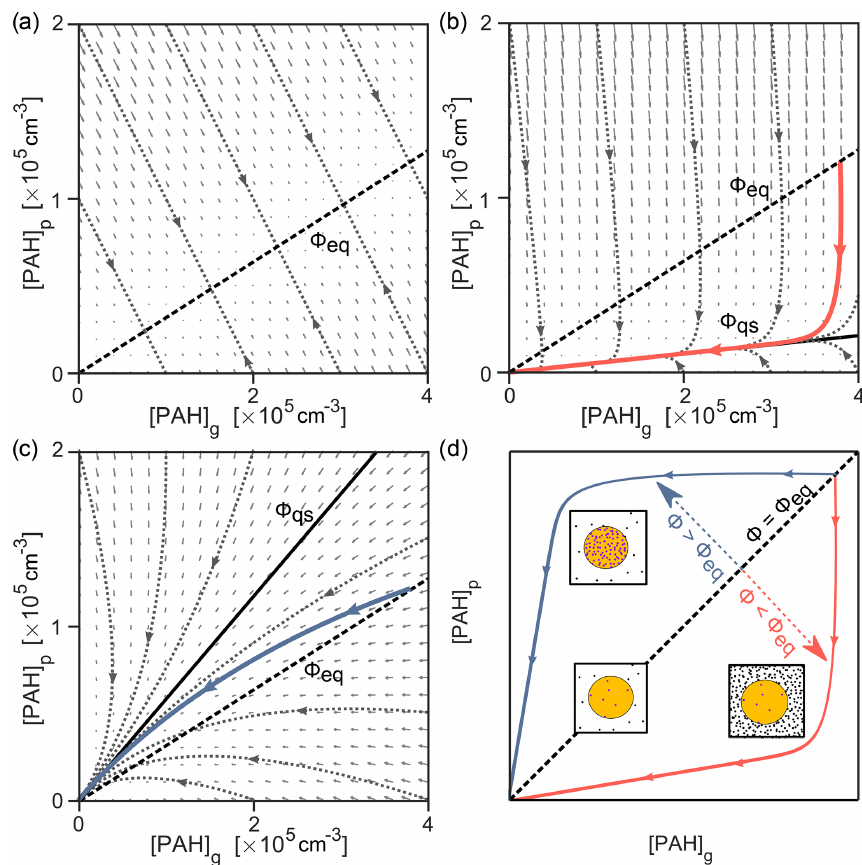
Figure 6. The interplay of partitioning and chemistry illustrated as simulated trajectories in the phase space of gas- and particle-phase concentrations, [ PAH ] g and [ PAH ] p , of pyrene. (a) Partitioning only, (b) partitioning and chemical loss from the particle phase due to surface reaction with O 3 (100ppb, red solid line), (c) partitioning and chemical loss from the gas and particle phase due to reaction with OH (1ppt, blue solid line), and (d) comparison to schematics in Fig. 2. The direction of each small gray vector arrow indicates the extent to which pyrene is being lost or transferred between phases, and its length is proportional to the rate of change. The nullcline representing equilibrium particulate fraction in panel (a) ( (cid:56) eq = 0 . 24, dashed black line) is shown in panels (b, c) , alongside the respective slow manifold representing the quasi-steady-state particulate fraction ( (cid:56) qs , solid black